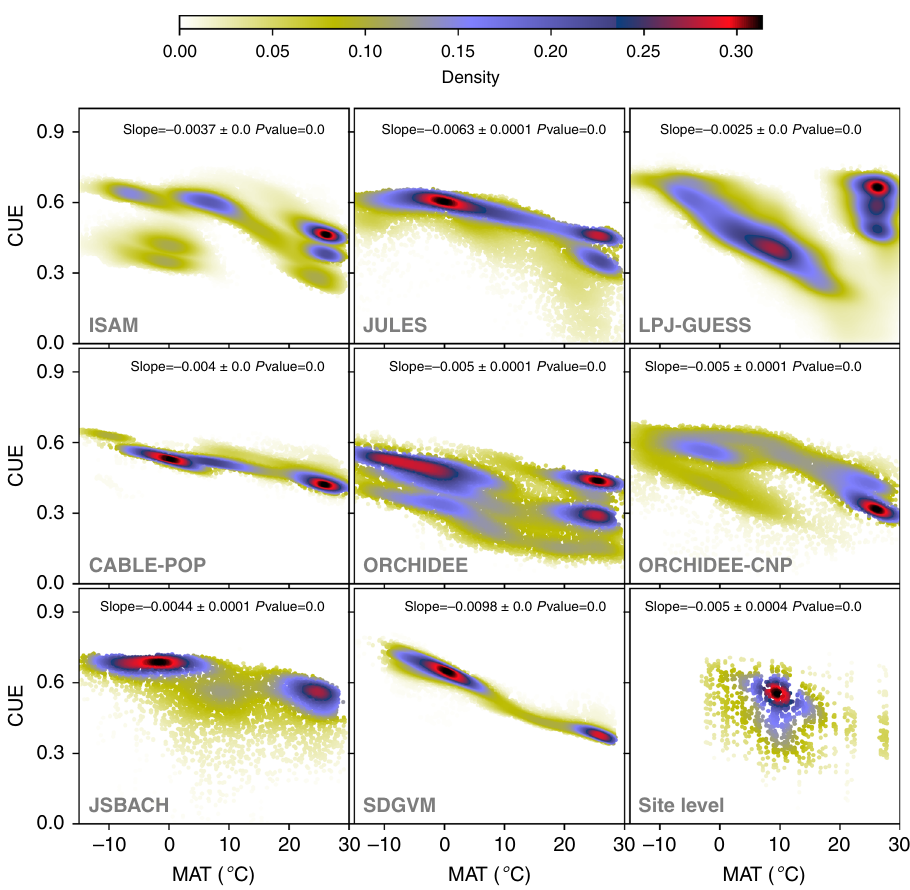
Fig. 5 Modelled TRENDY v.7 CUE and growth temperature patterns. Density plots (i.e. frequency of forest carbon use ef fi ciency (CUE) value divided by the total number of grid cells of simulated CUE derived from the following TRENDY v.7 process-based models: ISAM, JULES, LPJ-GUESS, CABLE-POP, ORCHIDEE, ORCHIDEE-CNP, JSBACH and SDGVM, averaged from 1995 to 2015 as function of MAT (°C). In the last (right bottom) density plot, data points extracted from coordinates and times of observed sites and used to plot the simulated CUE as function of MAT from the eight TRENDY v.7